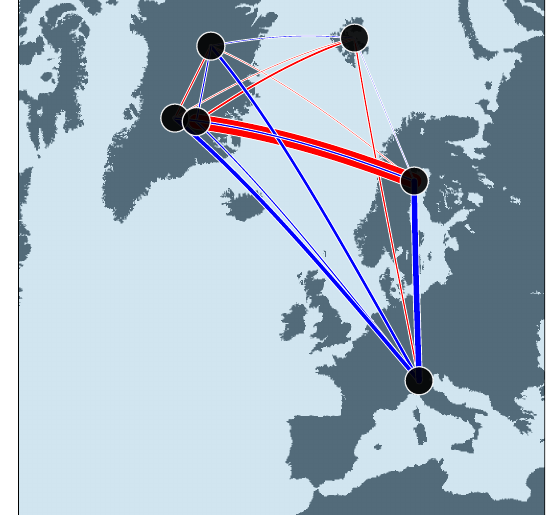
Figure 5. Regression coefficients between the 15 cross-link densities (CLD) among the spatial clusters of records and NAO Ortega,50 yr . Note that these linkages represent statistical rela- tions and do not necessarily relate to (temperature) teleconnections between different regions, but may also reflect common factors in- fluencing the respective regional climate dynamics as recorded by the proxies in a similar way. Black circles mark the centres of each group of records. Each line indicates the correlation between the CLD for two groups of records and the NAO reconstruction by Or- tega et al. (2015). Red (blue) colours indicate a positive (negative) sign of the coefficient, whereas the width of the drawn links is pro- portional to the mean coefficient value as given in Table